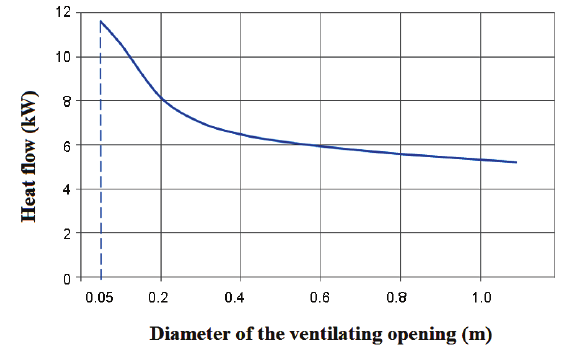
Fig. 11. Heat gain to the premises of the upper floor of the academic building (summer)